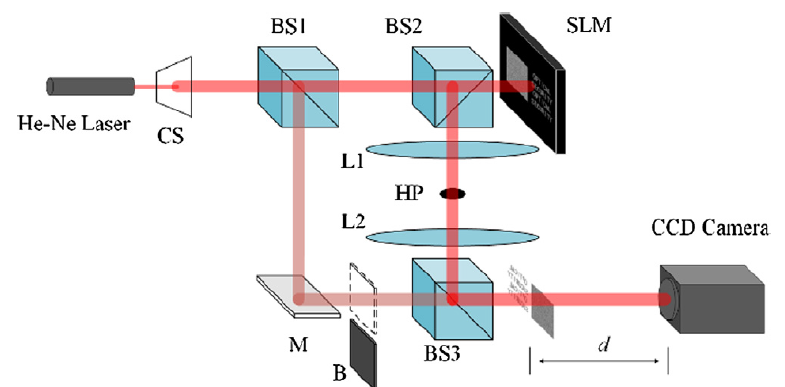
Figure 8. Encryption system based on a joint Fourier transform correlator (JFTC). Here, CS: collima- tion system; BS1, BS2, BS3: beam splitters; SLM: spatial light modulator; L1, L2: lenses; HP: high-pass filter; M: mirror; B: baffle; CCD: charged-coupled device